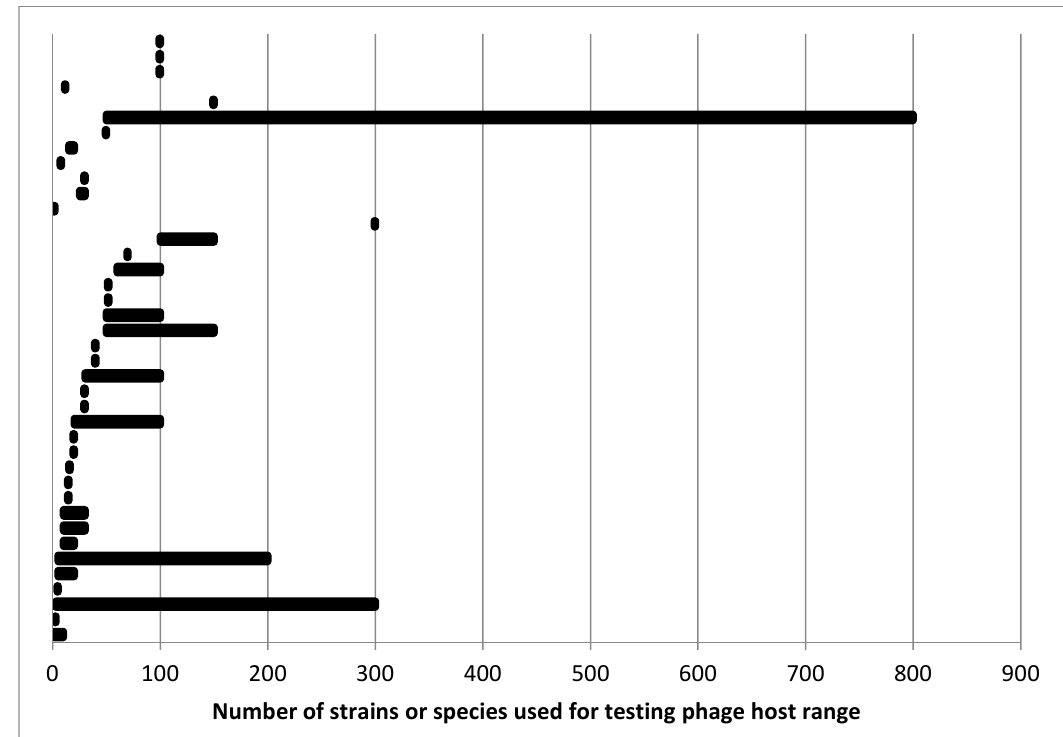
Figure 1. Responses to the question “How many strains do you actually use in testing host range?” The Y-axis is valueless with each horizontal line or point representing an individual response to the question.